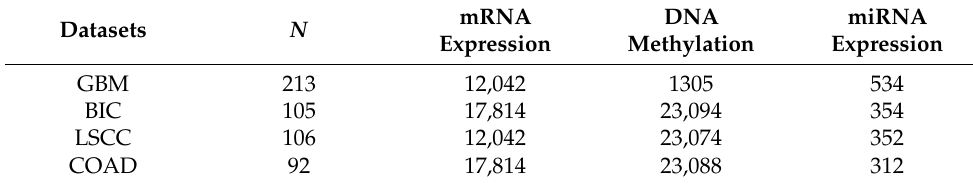
Table 3. Overview of the TCGA